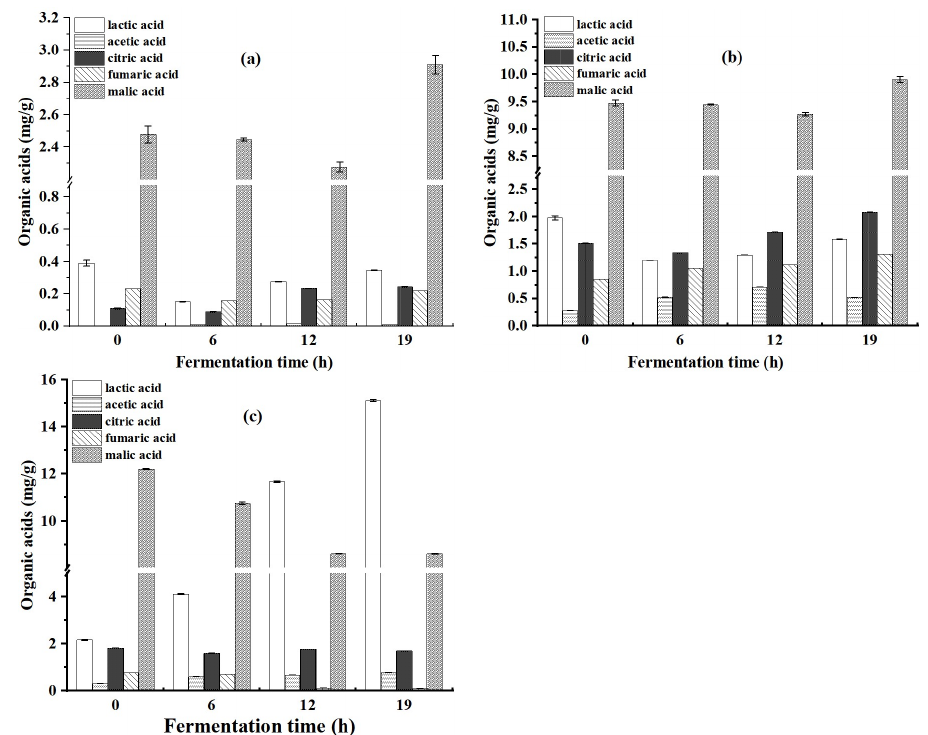
Figure 4. Effect of fermentation on the organic acid content of sourdoughs. ( a ) N-L-Y dough; ( b ) yeast dough; ( c ) DN-1 sourdough.